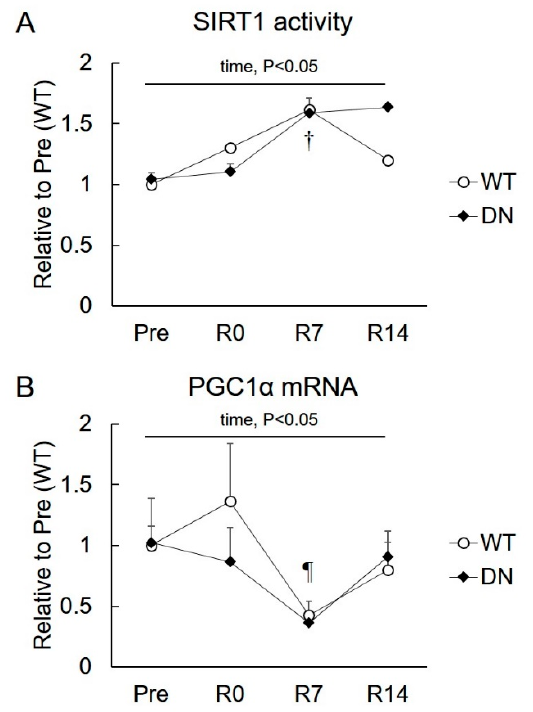
Figure 5. Changes in sirtuin 1 (SIRT1) activity and peroxisome proliferator-activated receptor gamma coactivator 1-alpha (PGC1 α ) mRNA expression after 14 days of hindlimb unloading, and at 0, 7, and 14 days of reloading. ( A ) SIRT1 activity; n = 3 per group. ( B ) PGC1 α mRNA; n = 8 per group. Values are means ± SE. Statistical results of two-way ANOVA (genotype, time, and genotype × time) are described in the Figure. †, significant difference from Pre independent of genotype. ¶, significant difference from R0 independent of genotype.